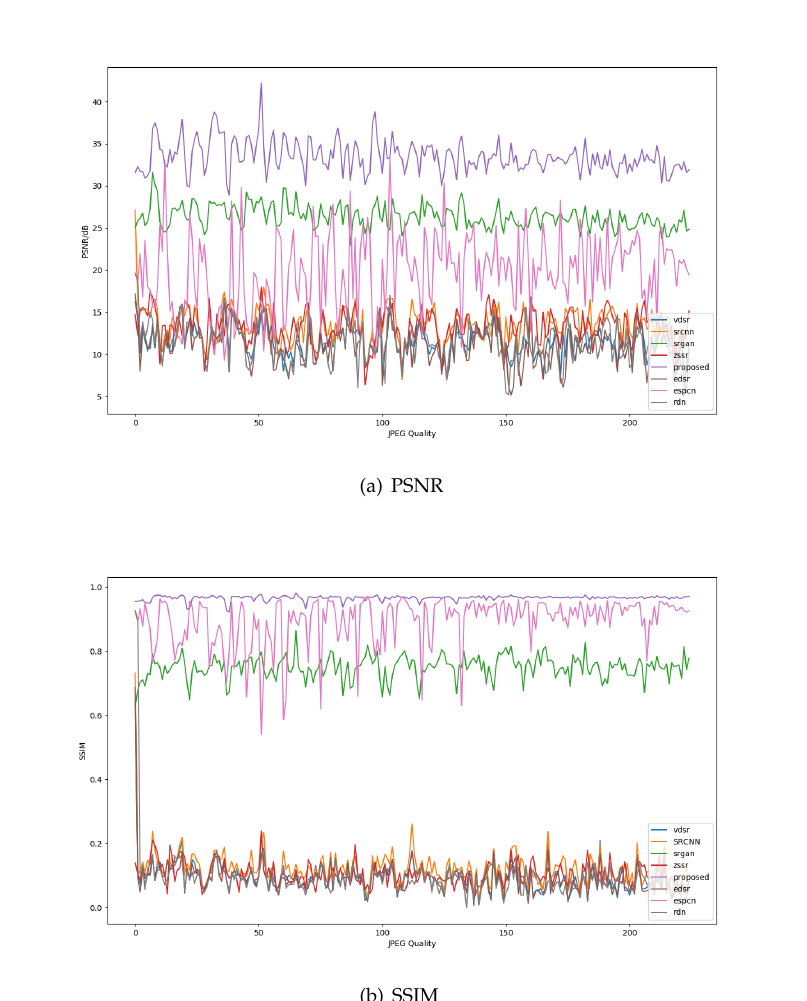
Figure 10. The metrics of GEO image (The proposed SAA-WGAN is the purple